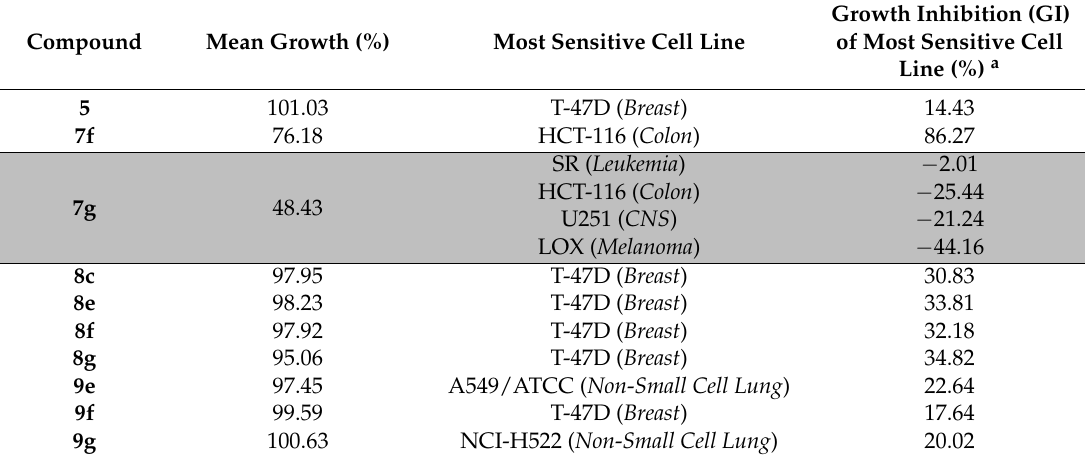
Table 1. Percentages of mean growth and growth inhibition of NCI human cancer cell lines treated with selected compounds ( 5 , 7f , g , 8c , e – g , 9e – g , 10d , e , g , 11b , c , e ) at one-dose of 10 µ M. Compound Mean Growth (%) Most Sensitive Cell Line